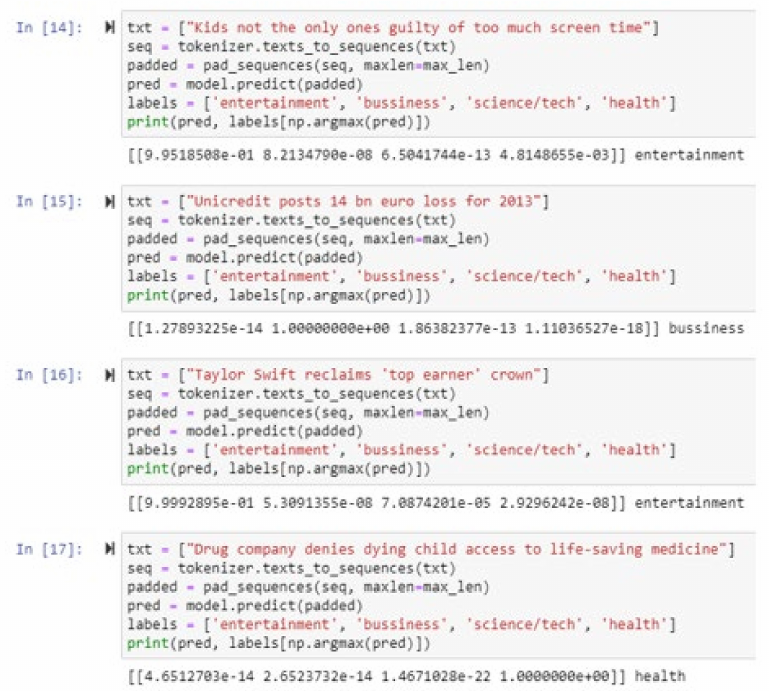
Figure 7. Sentence testing in [" "], with a total of four initial sentences, sentence trials from the dataset were directly entered in txt (one example of the test results of the File 22 program with program details as shown in Table 7).